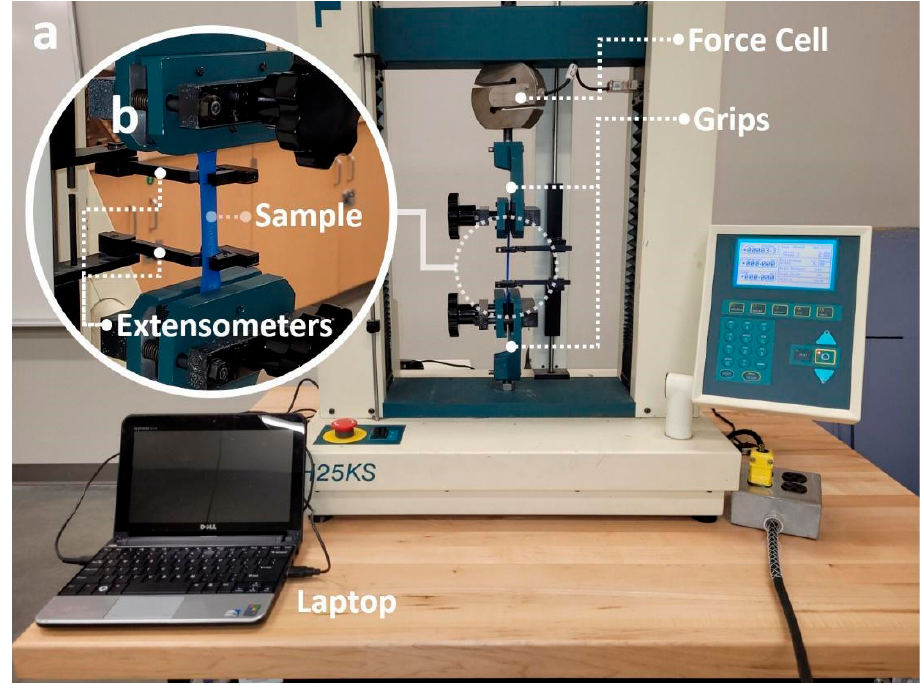
Figure 3. Mechanical characterization setup used for testing the 3D printed specimens: ( a ) apparatus used to perform the tensile tests, and ( b ) a close-up picture of the loaded specimen during the tests.